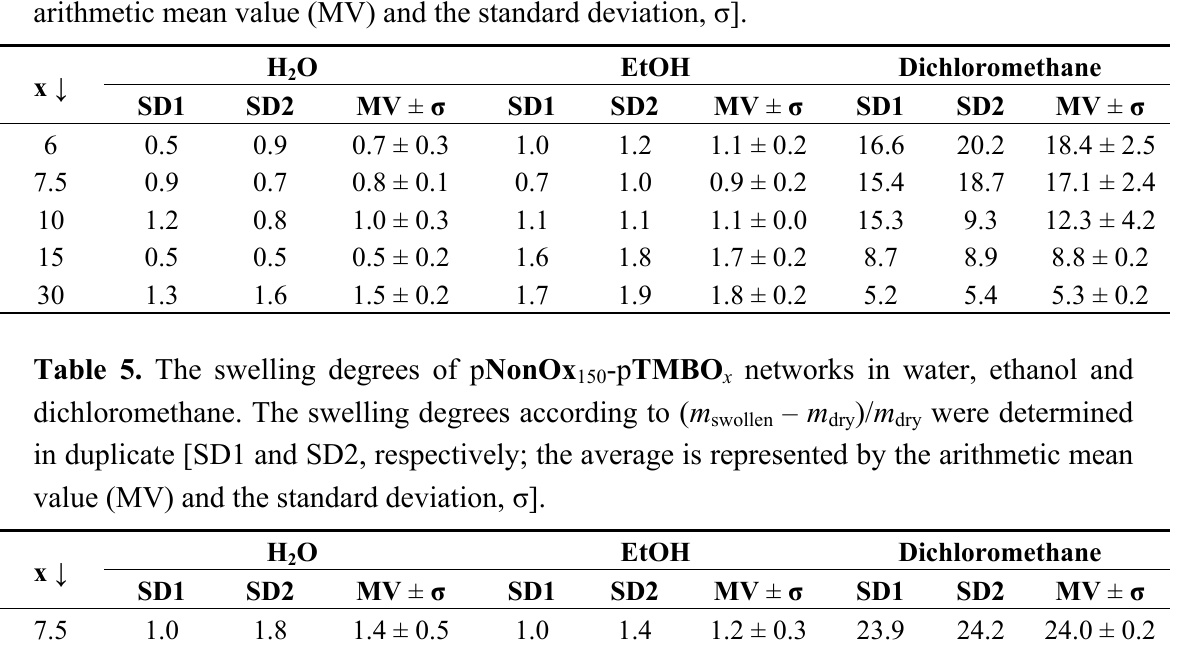
-p Dc = Ox -p TMBO networks in water, 100 50 x − m )/ m were swollen dry dry